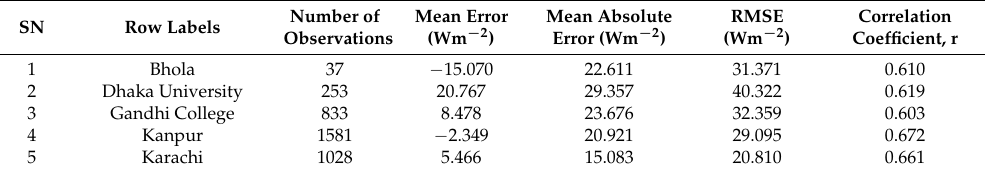
Figure 3. Comparison of estimated radiative forcing by using MODIS Aqua derived AOD and atmospheric water vapour with AERONET radiative forcing in the stations of IGP. ( a ) Bhola ( b ) Dhaka University ( c ) Gandhi College ( d ) Kanpur ( e ) Karachi ( f ) Kolkata ( g ) Lahore ( h ) Lumbini ( i ) New Delhi ( j ) Pantnagar. Table 9. Evaluation of the model with AOD and Atmospheric water vapour retrieved from MODIS Aqua in the IGP.